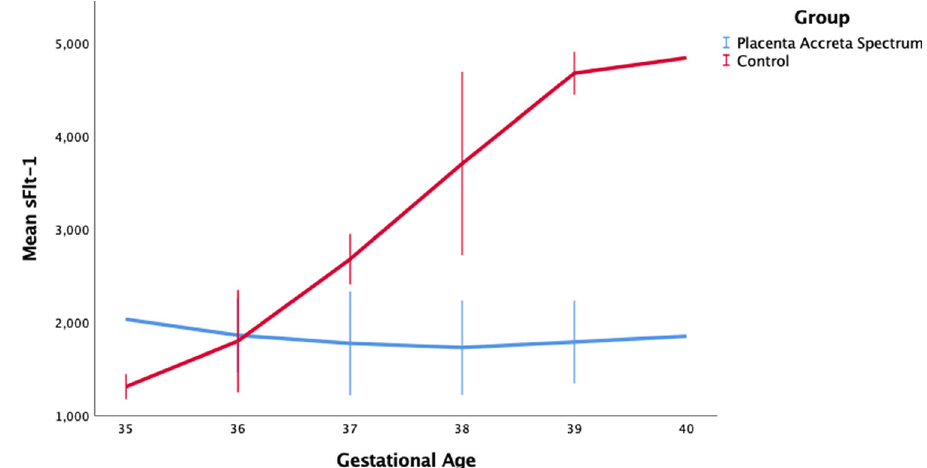
Figure 1. sFlt-1 level by gestational age between placentra acrreta spectrum (PAS) and control